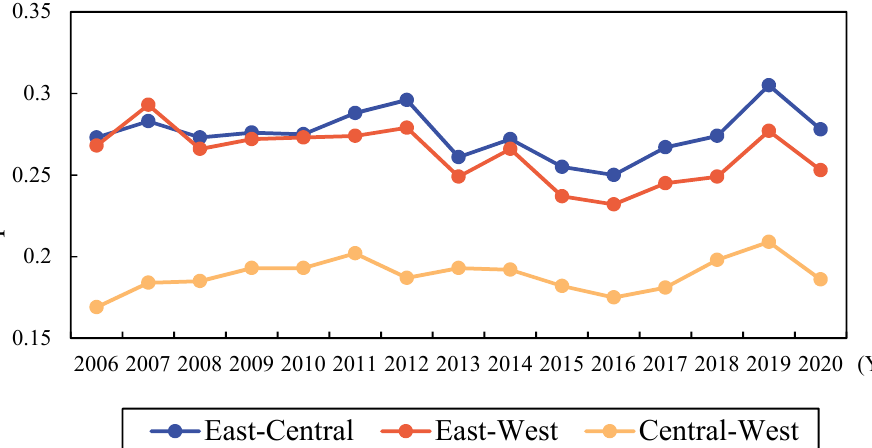
Figure 4. Variation of the Inter-regional Differences in the Livelihood Resilience of Rural Residents in China. Source: the authors’ own work.